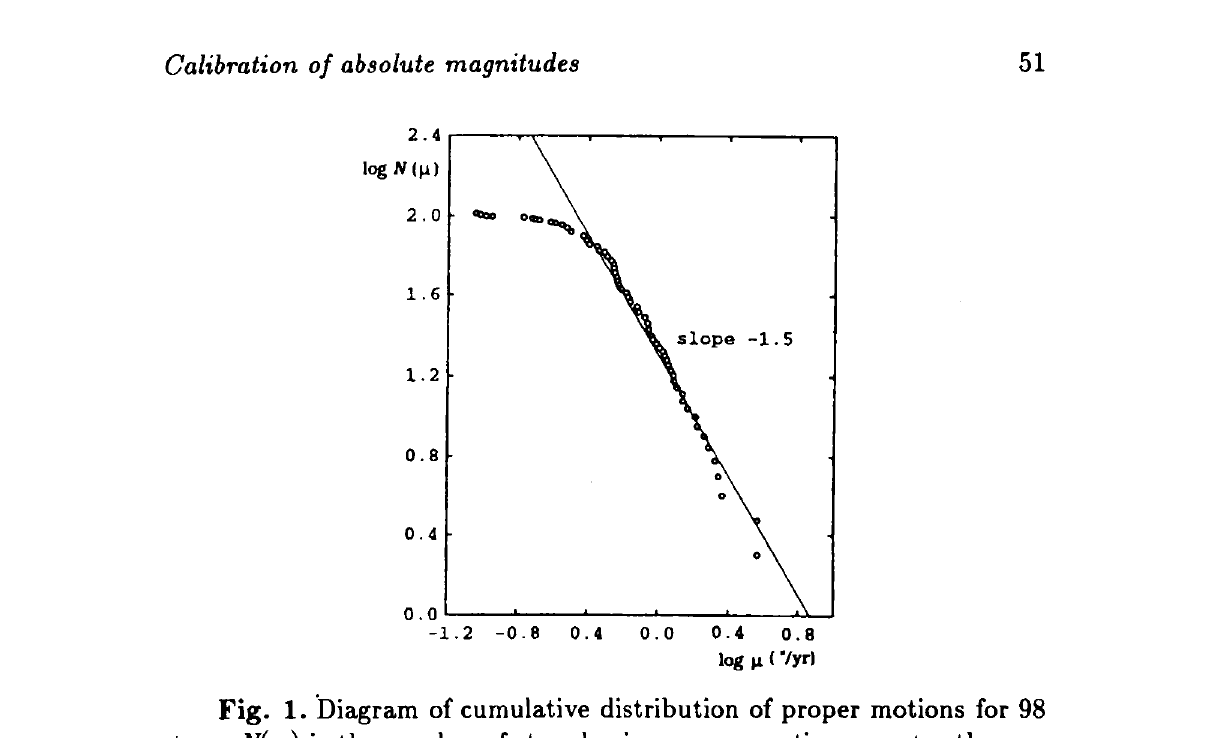
Fig. 1. Diagram of cumulative distribution of proper motions for 98 stars. N(fi) is the number of stars having proper motions greater than